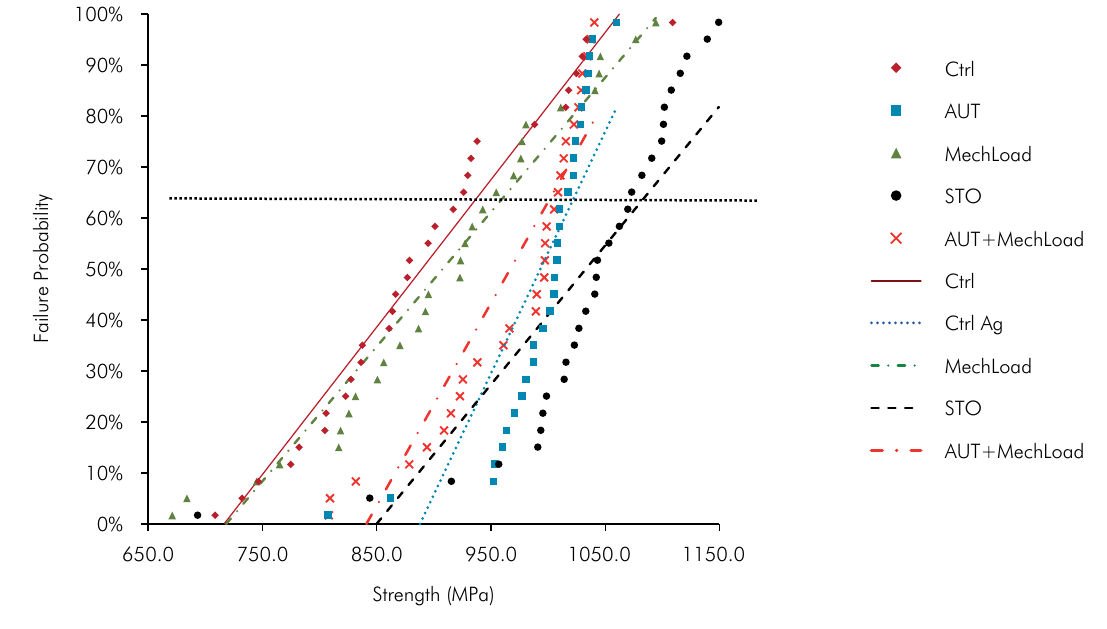
Figure 3. Weibull Plots from strength data (MPa) and failure